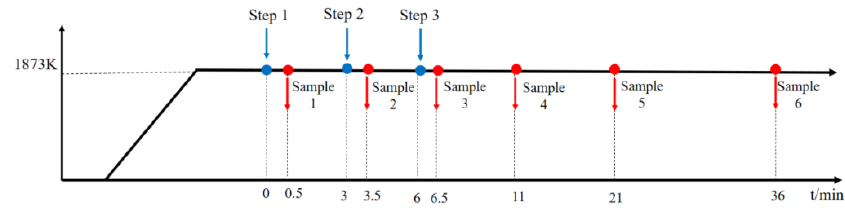
Figure 1. Atmosphere protection resistance furnace for test. Figure 1 . Atmosphere protection resistance furnace for test. Figure 1 . Atmosphere protection resistance furnace for test.